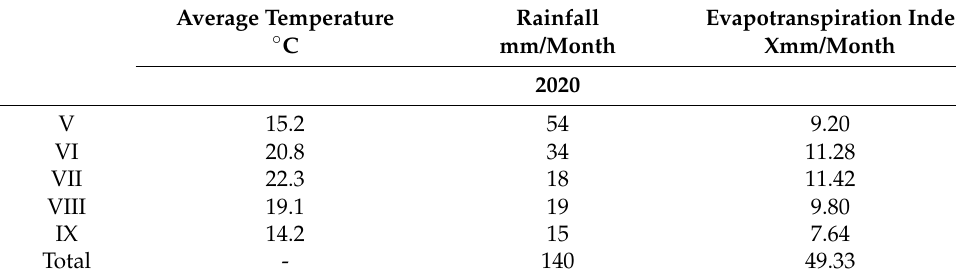
Table 5. The course of weather conditions in the area of research.